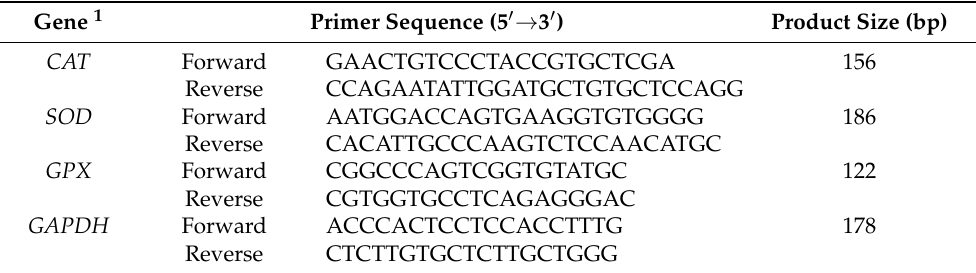
Table 1. Primer sequences for